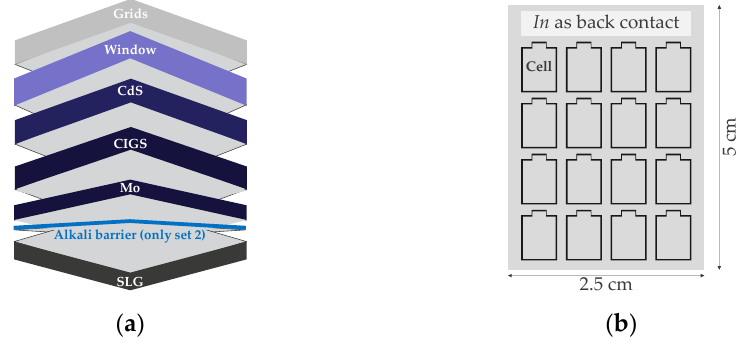
Figure 2. Schematic of the solar cell devices stack ( a ) and top view ( b ).